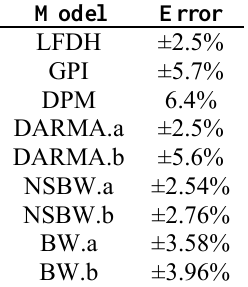
Table 2. Comparison results of modeling error.